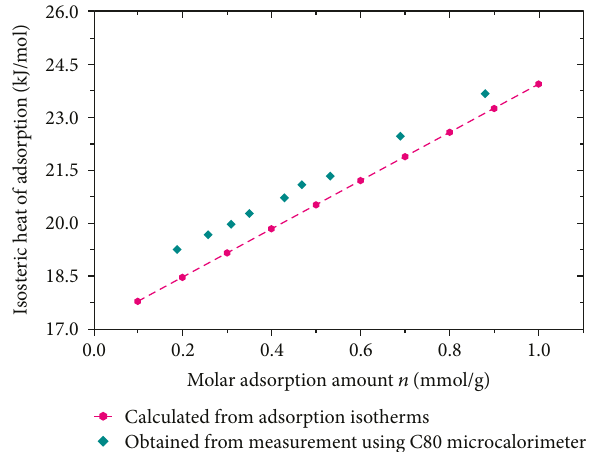
Figure 6: Comparison between isosteric heat of adsorption obtained from adsorption isotherms and that obtained from calorimetric